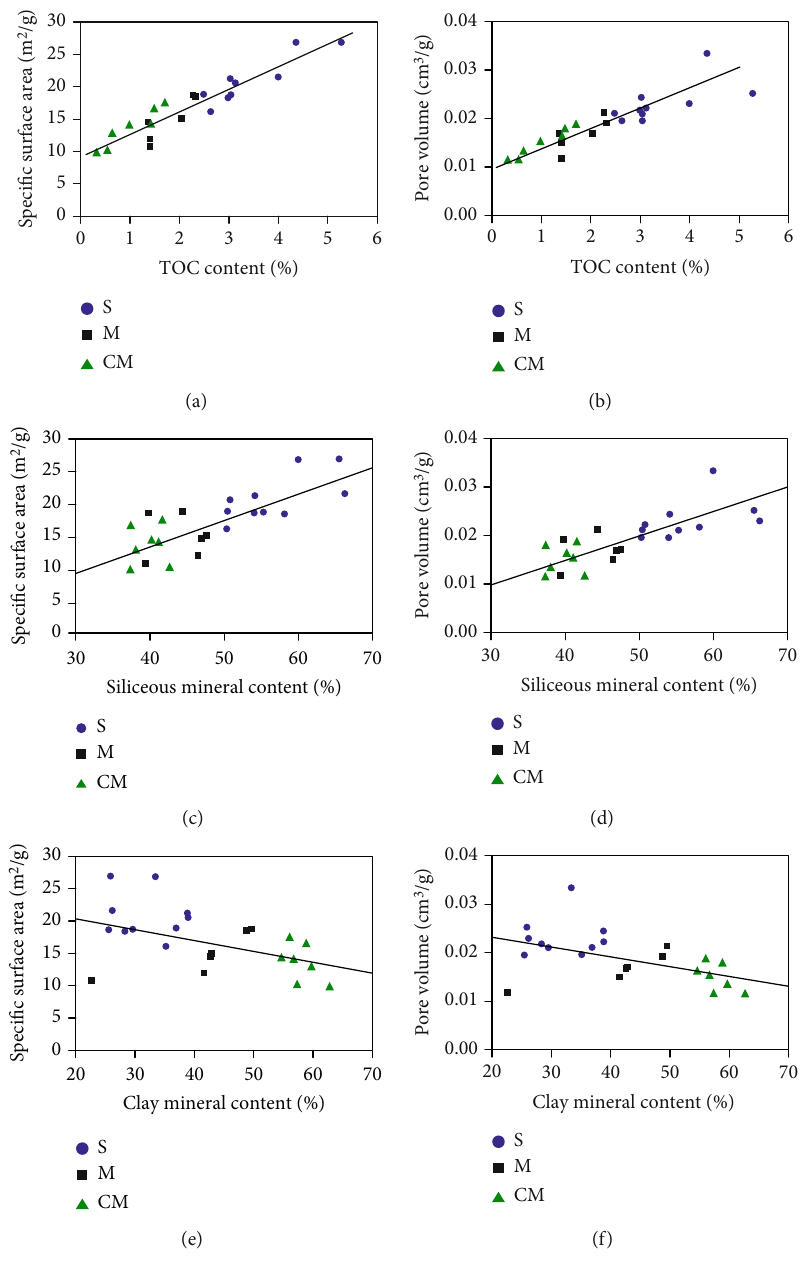
Figure 12: The relationship between (a) TOC content and speci fi c surface area, (b) TOC content and total pore volume, (c) siliceous mineral content and speci fi c surface area, (d) siliceous mineral content and pore volume, (e) clay mineral content and speci fi c surface area, and (f) clay mineral content and pore volume of shale